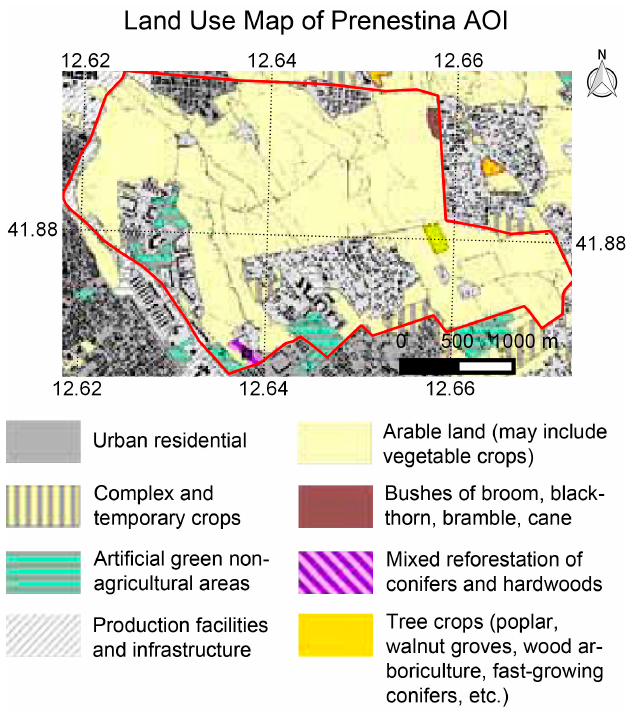
Figure 25. Land use map of Prenestina AOI (shown in red polygon), last updated in 2007. Copyright: Comune di Roma [64].